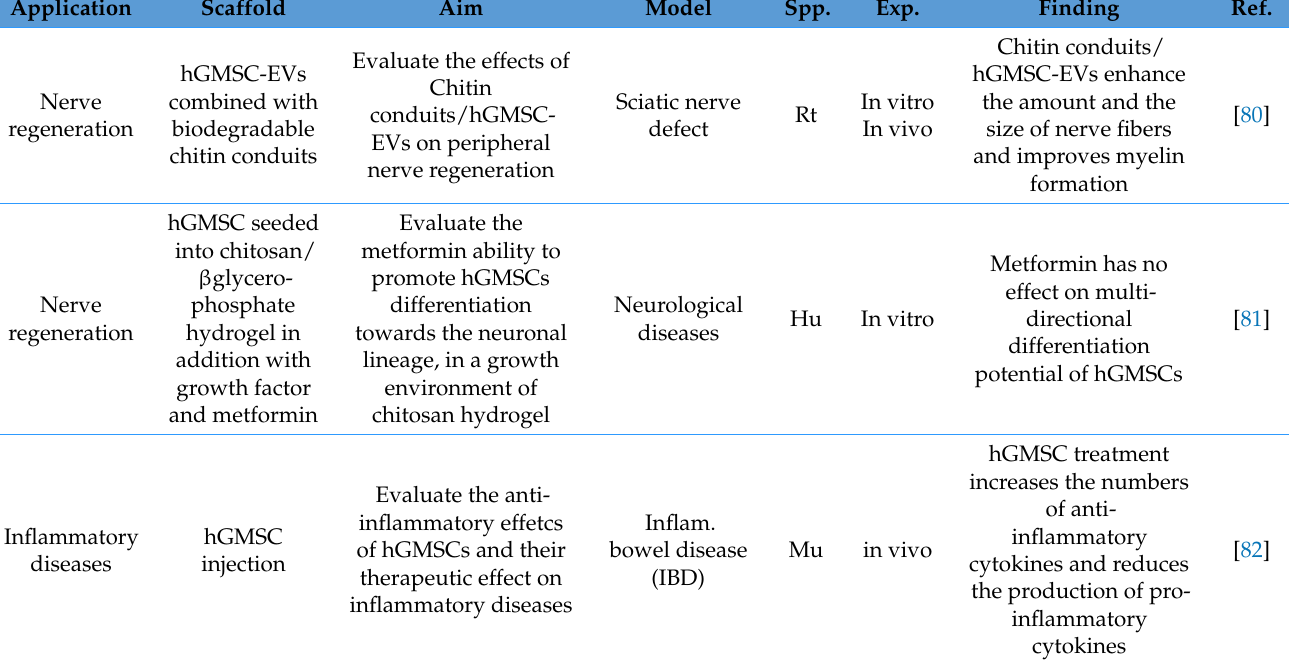
Table 7. hGMSCs application in regenerative